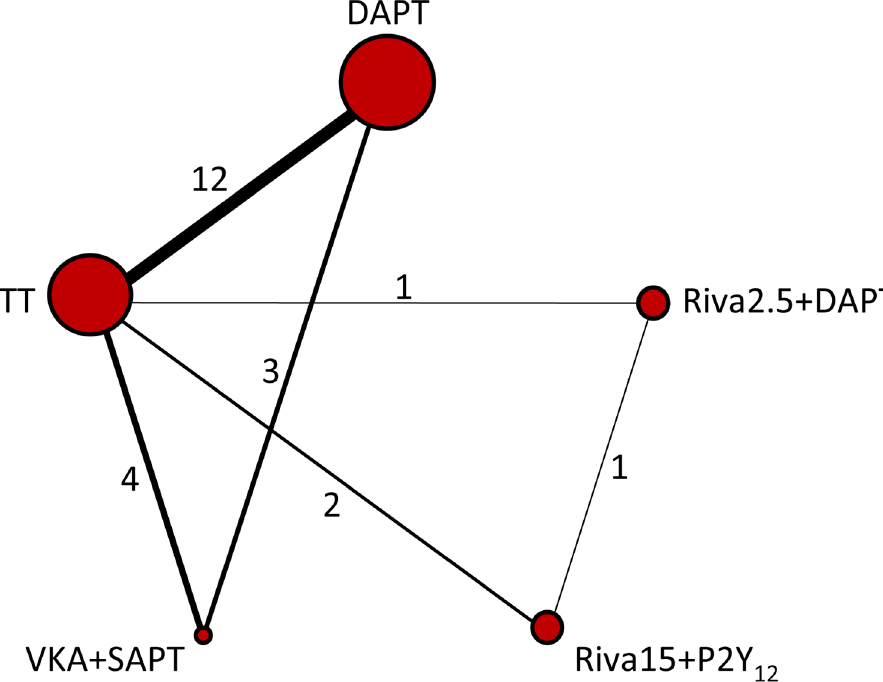
Fig 2. Network diagram of treatment comparisons for MACCEs and major bleeding of competitive antithrombotic regimens. MACCEs, main adversecardiac and cerebrovascular events; DAPT, dual- antiplatelet therapy; TT, triple-antiplatelet therapy; VKA, vitamin K antagonist; SAPT, single antiplatelet therapy; Riva15+ P2Y 12 , rivaroxaban 15 mg/d plus P2Y 12 inhibitor;Riva2.5 + P2Y 12 , rivaroxaban2.5 mg bid plus P2Y 12 inhibitor.The size of each node is proportional to the overallsample size of the corresponding therapy. Each line representsthe direct comparisonbetweentwo treatments, and the correspondingwidth is proportional to the numberof trials. Number next to the line indicatesthe specific number of